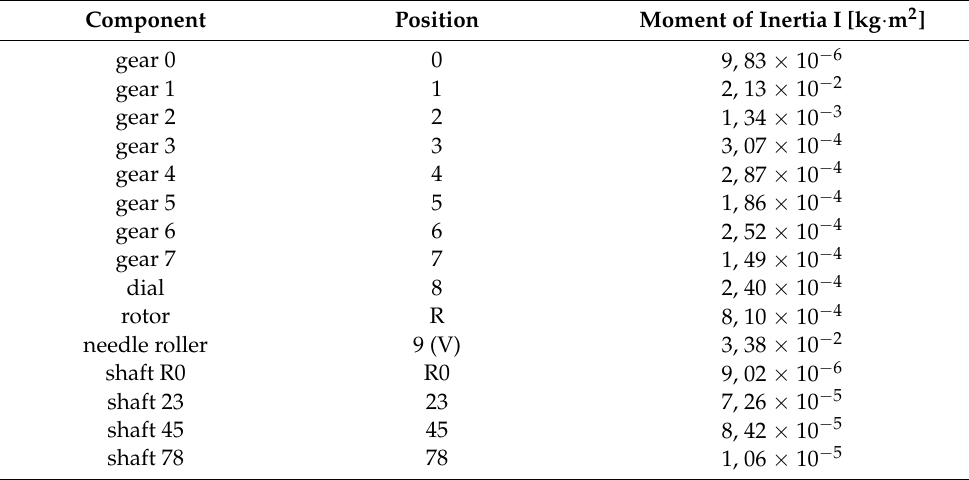
Table 1. Moments of inertia of the considered parts of the drive system. Component Position Moment of Inertia I [kg · m 2 ]